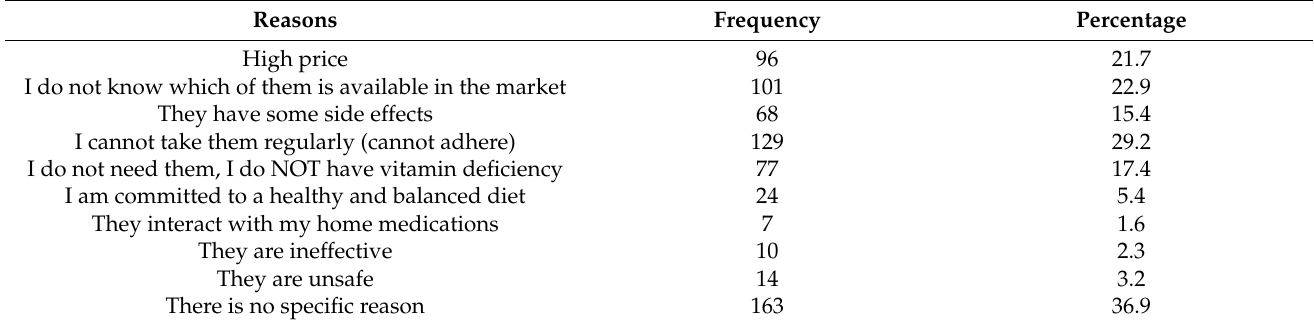
Table 6. Reasons for not taking dietary supplements during the COVID-19